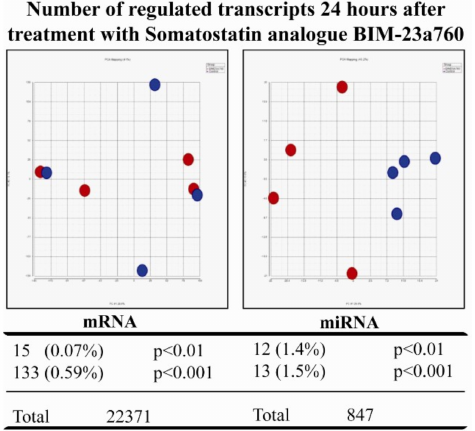
Figure 2. The dual somatostatin-dopamine agonist BIM-23a760 induces greater changes in microRNA (miRNA) than in messenger RNA (mRNA). Carcinoid NCI-H727 cells were treated with the dual somatostatin-dopamine agonist BIM-23a760 for 24 h and the changes in mRNA and miRNA were examined using microarray. Principal component analysis (PCA) of the changes in mRNA and miRNA demonstrated that mRNA based PCA did not clearly separate the BIM-23a760 treated cells (shown in red) from the control cells treated with vehicle without BIM-23a76 (shown in blue). In contrast a PCA based on the changes in miRNA expression clearly separated the treated cells (shown in red) from the untreated cells (shown in blue). This suggests that the miRNA changes induced by BIM-23a760 are more specific than the changes in mRNA expression. This was also supported by the fact, that a higher proportion of miRNA transcripts than of mRNA are changed by BIM-23a760